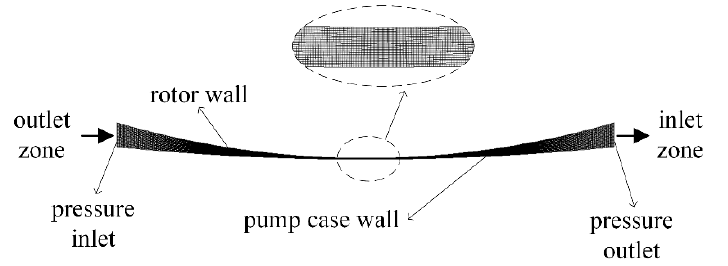
Figure 13. Two-dimension model of the gap between the rotor and the case (not to scale).